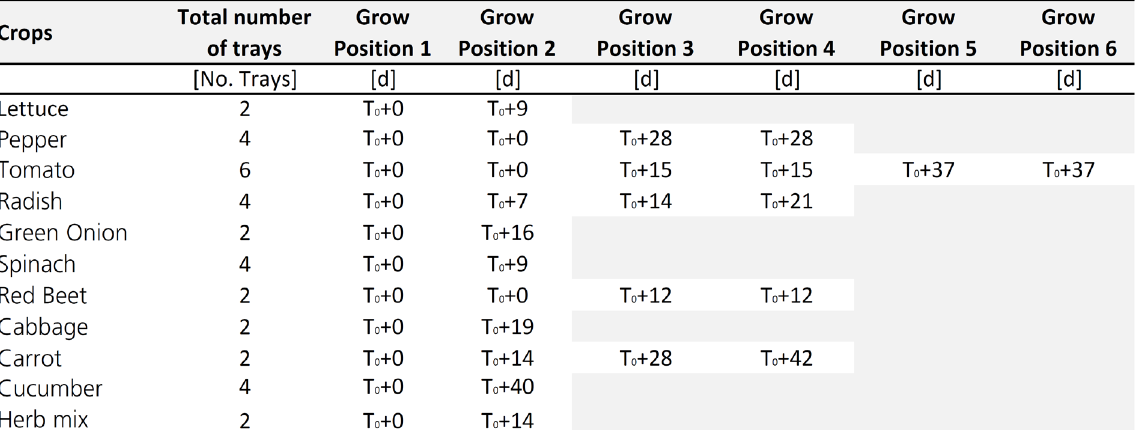
Table 6: Initiation times for each tray and crop type for the SC approach. Depending on the total number of trays per crop type, different starting points are defined. Depending on the total production lifecycle and the harvest pattern, some trays are initiated in a parallel, e.g. tomato with 6 trays, where 2 trays start at the same time (T+0, +15,